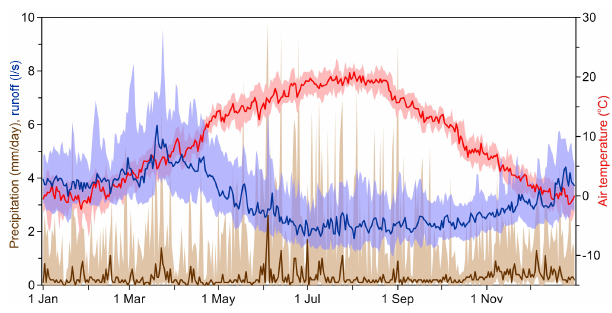
Figure 3. Precipitation and air temperature at the weather station, and runoff at the catchment outlet (MW) of the HOAL. Lines show medians of the period 1990–2014, shaded areas the 25 and 75% percentiles based on the data aggregated to daily values.